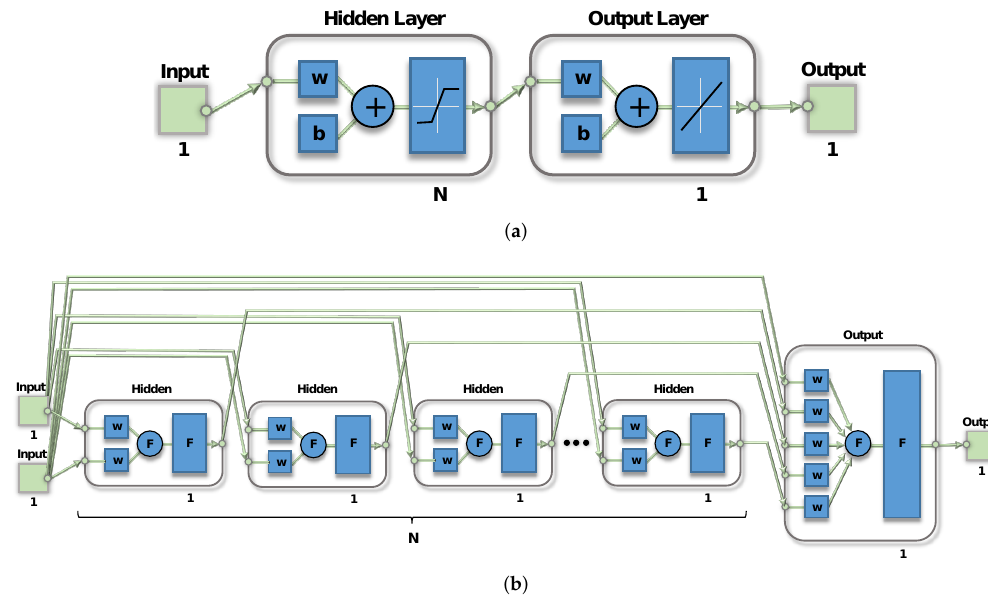
Figure 9. ( a ) ANN defined by Matlab with N processors in a single layer and ( b ) modified ANN definition with each processor in an independent